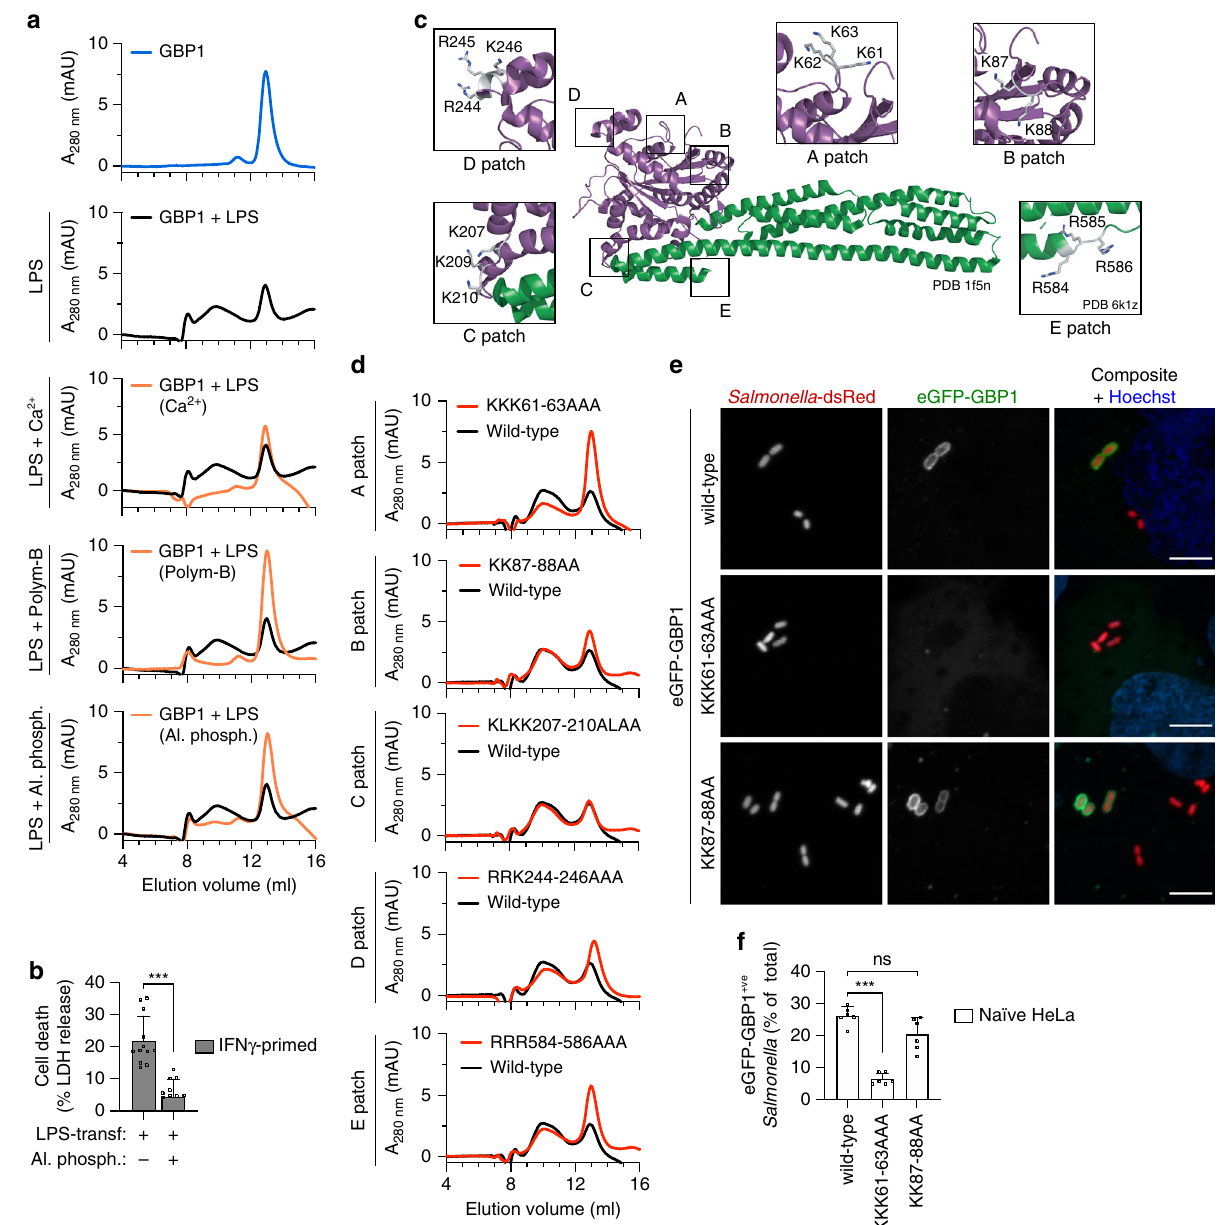
Fig. 7 GBP1 is recruited to the bacterial surface and binds LPS through electrostatic interactions. a Size exclusion chromatograms of recombinant His- tagged GBP1 incubated with E. coli LPS, or with E. coli LPS pre-treated with CaCl 2 (5mM), Polymyxin B (10 µ g/mL) or with alkaline phosphatase. Curves were corrected by subtracting the respective LPS-speci fi c absorbance at 280nm. Black curves representing control condition were overlayed. b Release of LDH from IFN γ -primed HeLa 5h after transfection with E. coli LPS, or after transfection with LPS previously treated with alkaline phosphatase. c 3D structure of human GBP1 (PDB 1f5n), highlighting fi ve different negatively charged patches (A to E). Residues comprising patch E are only visible in PDB 6k1z. For each patch, the indicated residues were all mutated to alanines and analyzed for GBP1-LPS interaction by size exclusion chromatography. Purple indicates GTPase domain, green indicates helical domain. d Size exclusion chromatograms of different His-tagged GBP1 mutants incubated with E. coli LPS. Curves were corrected by subtracting LPS-speci fi c absorbance at 280nm. e Fluorescence confocal microscopy of naive HeLa expressing eGFP-GBP1 wt , eGFP-GBP1 KKK61-63AAA or eGFP- GBP1 KK87-88AA and infected with Salmonella -dsRed for 1h. DNA was stained with Hoechst (blue). Representative confocal images are shown and scale bar corresponds to 5 µ m. f Percentage of eGFP-GBP1 positive Salmonella at 1h p.i., as quanti fi ed by counting between 100 – 200 bacteria per coverslip. Graphs show the mean±SD, and data are pooled from three independent experiments performed in duplicate ( f ), four independent experiments performed in triplicate ( b ), or are representative from three ( a , d , e ) independent experiments. *** P <0.001; ns, not signi fi cant, two-tailed t